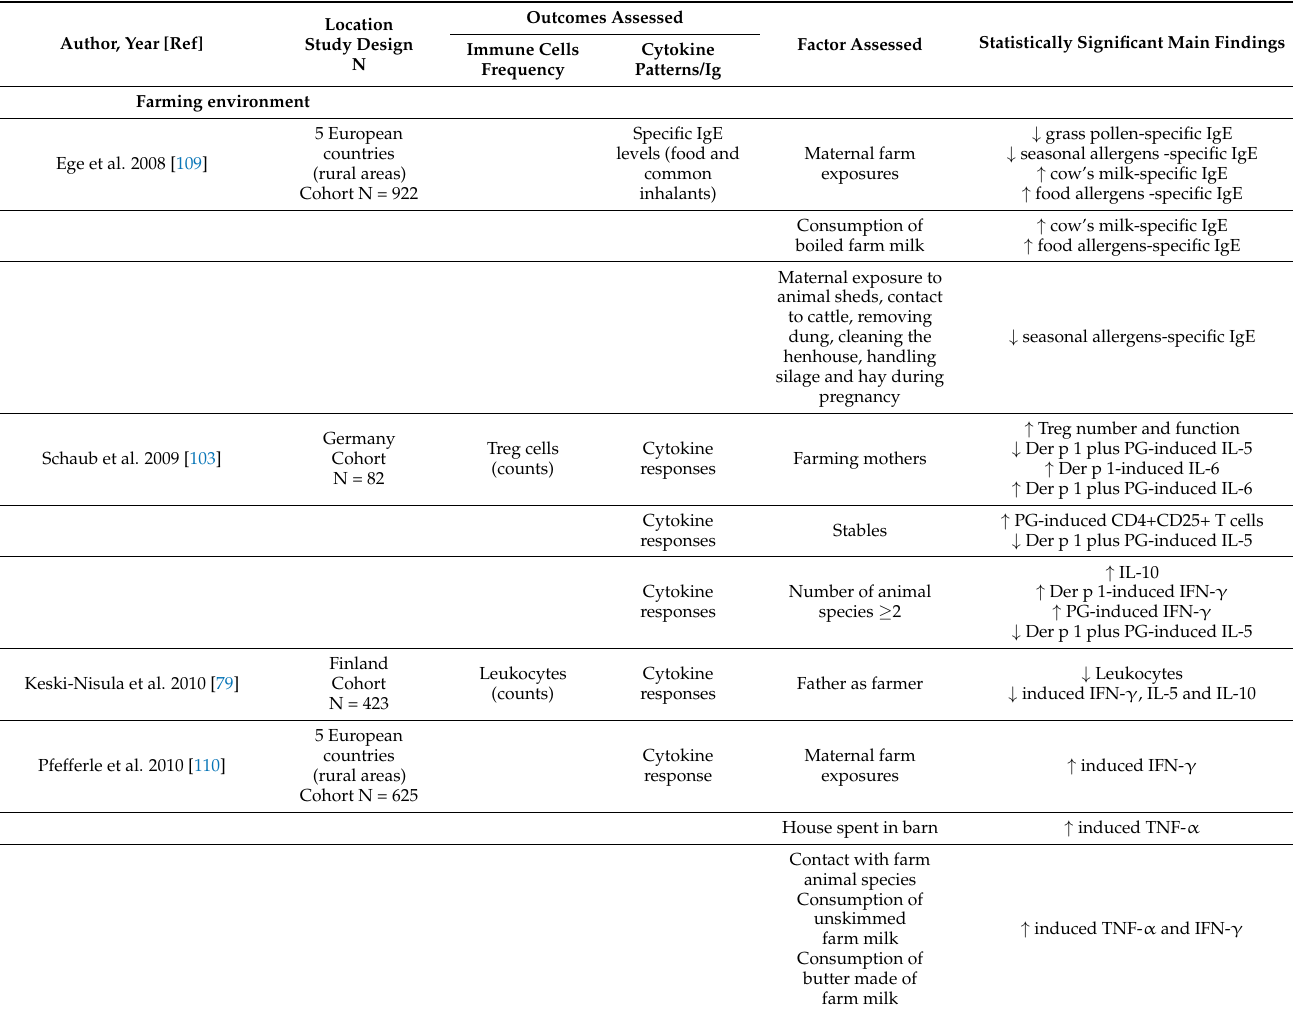
Table 3. Prenatal exposure to a farming environment, pets and common allergens and changes in the immune system of neonates (authors ordered by exposure, year and then